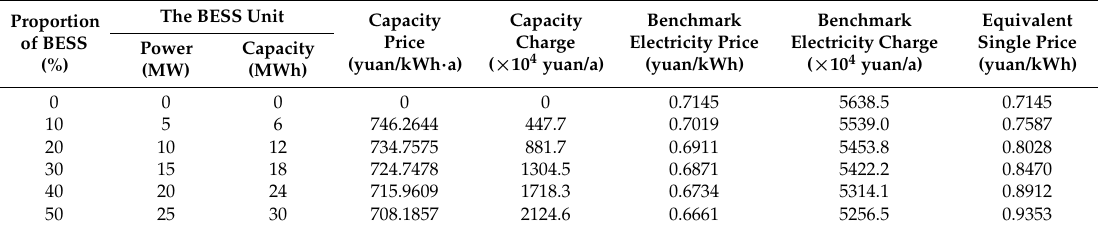
Table 7. The capacity price and the benchmark electricity price with different proportions of BESS. Proportion of